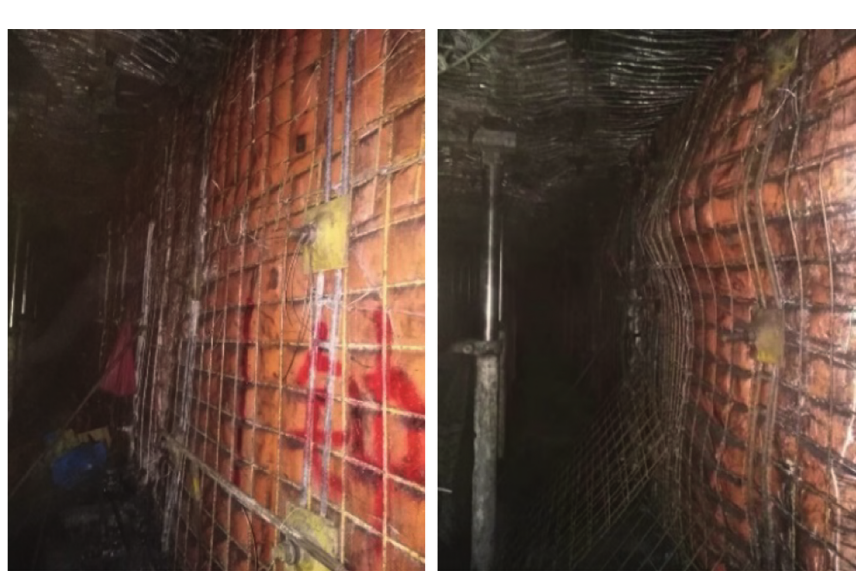
Figure 11: GER implementation effect of the #1301 working face in Licun Coal Mine.